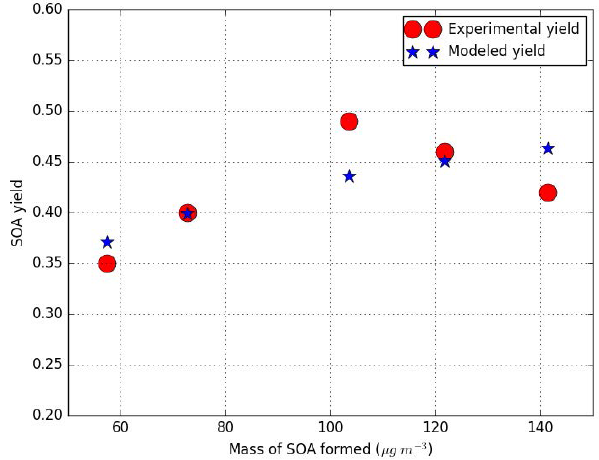
Figure 2. SOA yield data from smog chamber under low-NO x con- ditions (Nakao et al., 2011), and yield curve for cresol–OH reaction using one-product